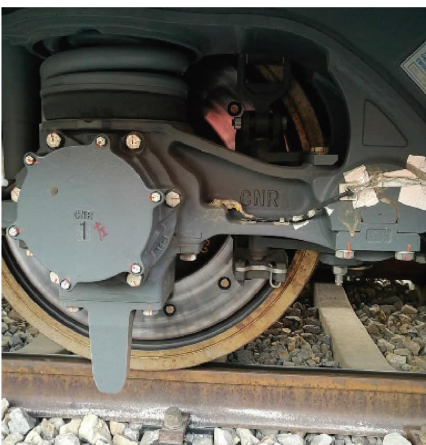
Figure 20: Te long-term tracking test of Fuxing Hao.